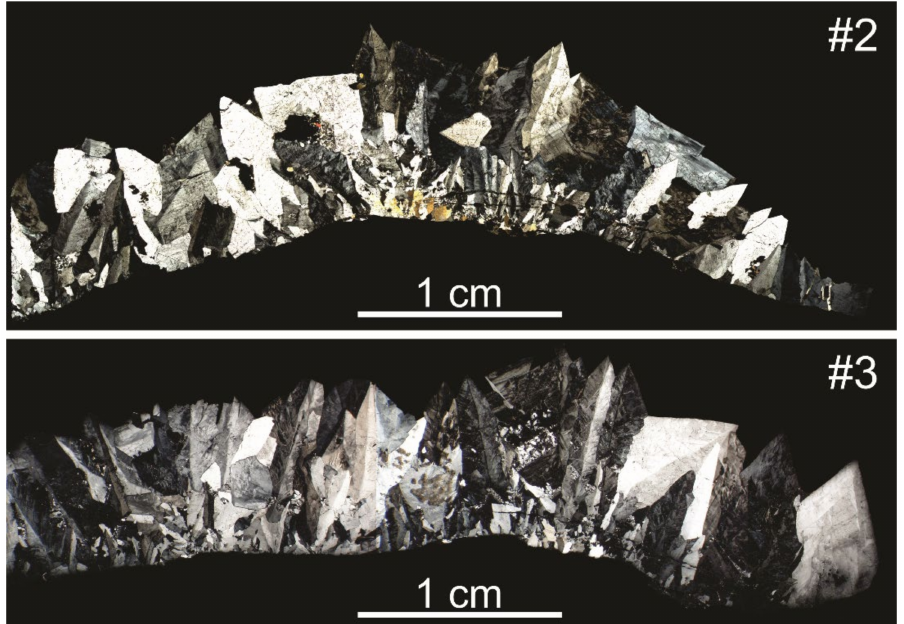
Figure 4. Photomicrographs of valencianite samples #2 and #3 (Figure 2) showing diverse textures in thin sections. The figure is a mosaic of photographs made with an AxioImager A2.m microscope using crossed polarizers and a × 2.5 objective.